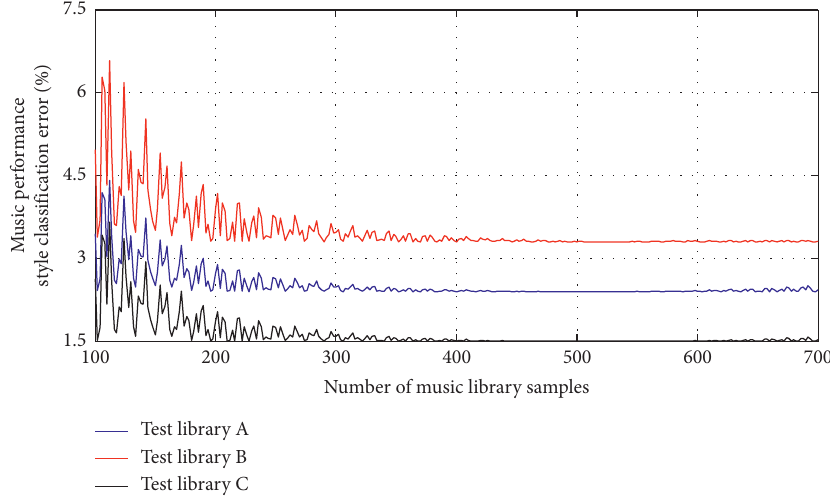
Figure 6: Classification error of three music libraries.